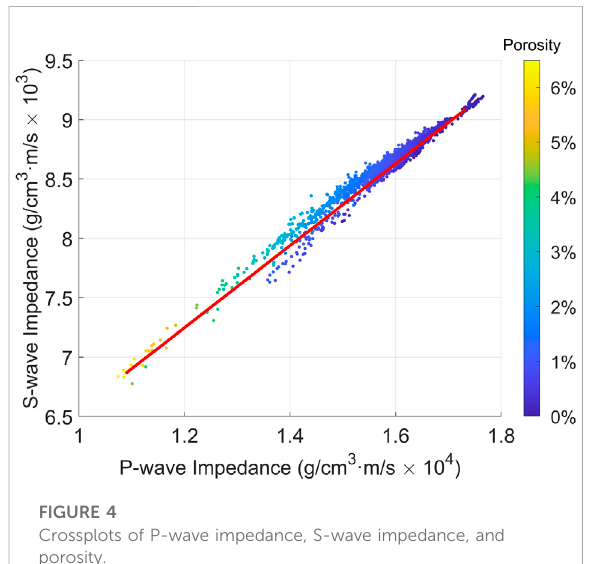
Crossplot of the PI and physical property indicator vs. porosity for Well